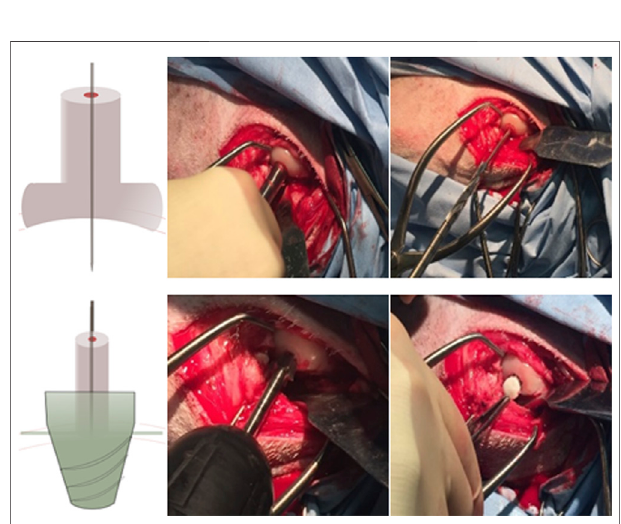
FIGURE 2 | Presurgical operation procedure: 1 – 3. Drill the small hole located by a drill sleeve and insert a pin guide into the hole; 4 – 5. Access the driller bite to create a larger hole, and use special design roam to create a truncated cone hole; and 6. Place the mountain scaffold into the osteochondral